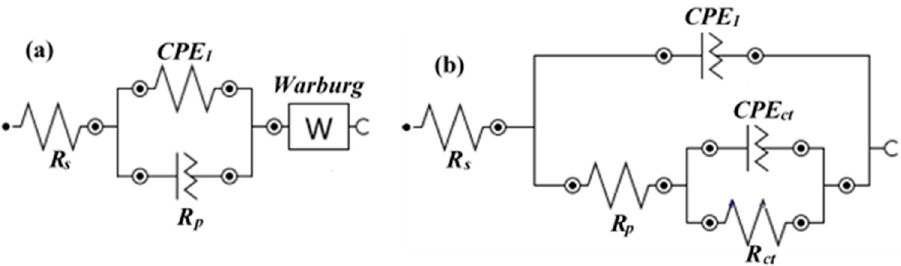
Figure 5. EEC of ( a ) SP-0 and ( b ) SP-1 to SP-2 samples from 1–168 h of exposure. The CPE coefficient ( Q eff ) can be calculated by Equation (1) with the CPE exponent ( n ) ≠ 1 [47].